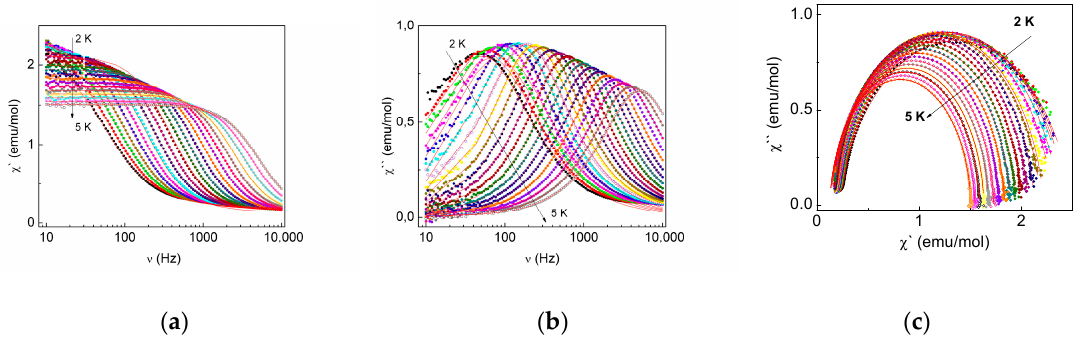
Figure 7. The frequency dependence of the χ ′ ( a ) and χ ′′ ( b ) under a magnetic field H = 1500 Oe and the Cole–Cole diagram ( c ) at different temperatures for 4-Er .